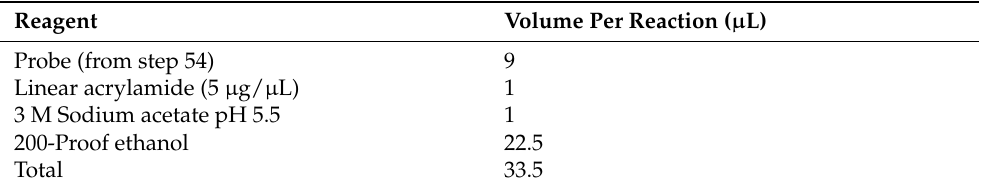
Table 11. Reaction mix for probe